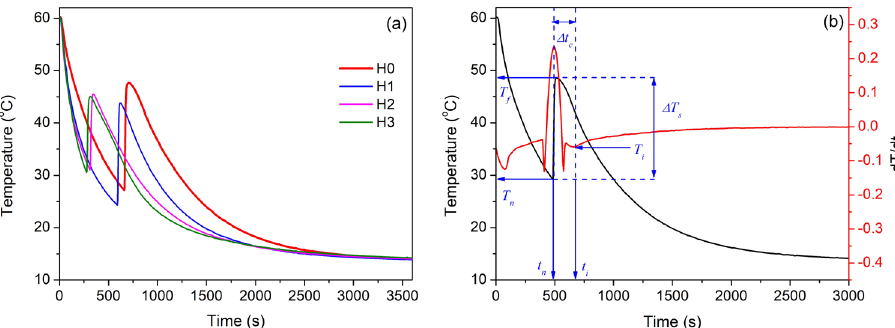
Figure 2. (a) Temperature profile during solidification under different magnetic field intensities. (b) Temperature vs time (black curve) and temperature derivative curve (red line) of CoNHH during